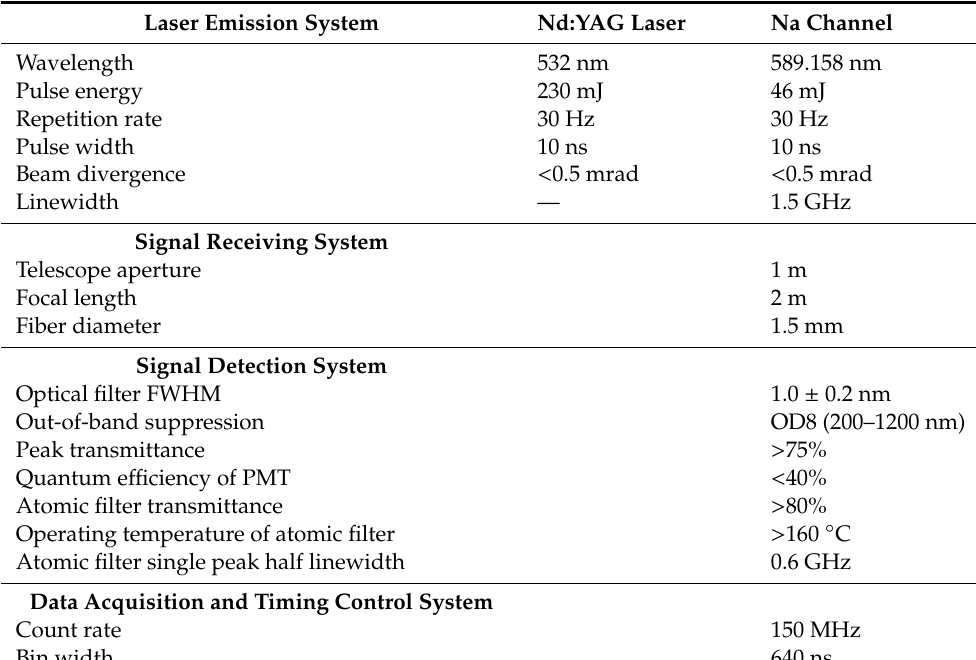
Table 1. The main parameters of lidar